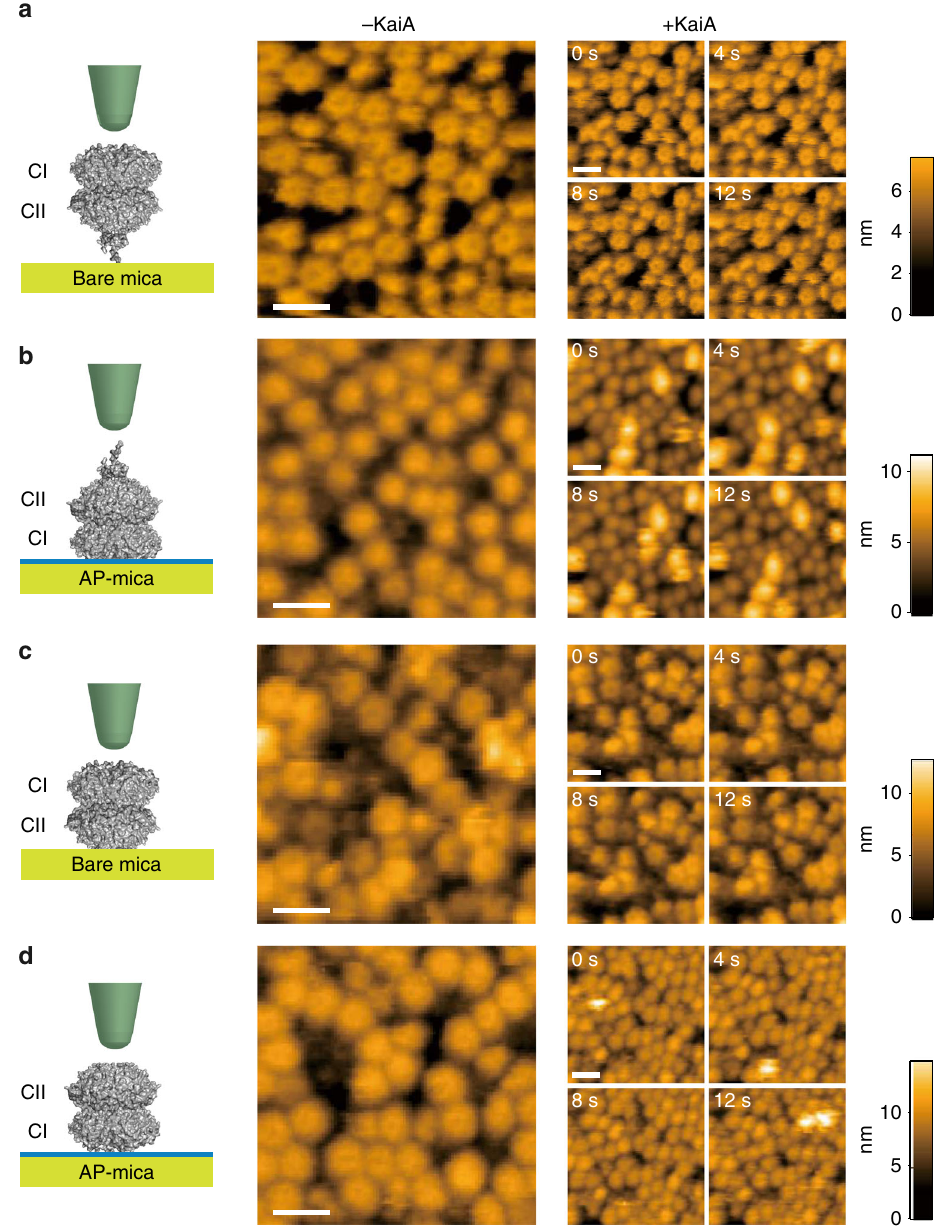
Fig. 1 Orientation-speci fi c immobilization of KaiC WT and interaction with KaiA. a KaiC WT on bare mica without (middle) and with (right) the addition of KaiA. b KaiC WT on AP-mica without (middle) and with (right) the addition of KaiA. c KaiC with deletion of C-terminal tentacles (KaiC- Δ C) on bare mica without (middle) and with (right) the addition of KaiA. d KaiC with deletion of C-terminal tentacles (KaiC- Δ C) on AP-mica without (middle) and with (right) the addition of KaiA. All images shown in the middle and the right columns were acquired at a frame rate of 1 fps and 1.25 fps, respectively. The images on the right columns are shown every 4 s. Scale bar = 15 nm. Also see Supplementary Movies 1 –